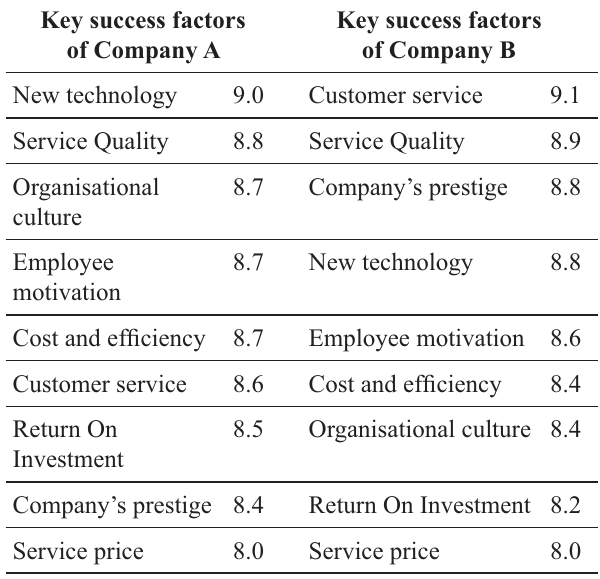
Table 1. Key success factors of two companies